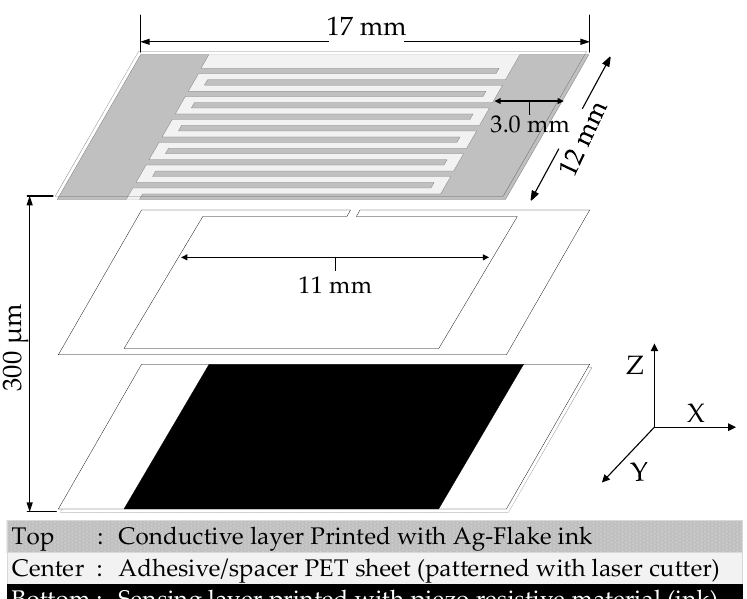
Figure 2. Exploded view structure of a sensing element.